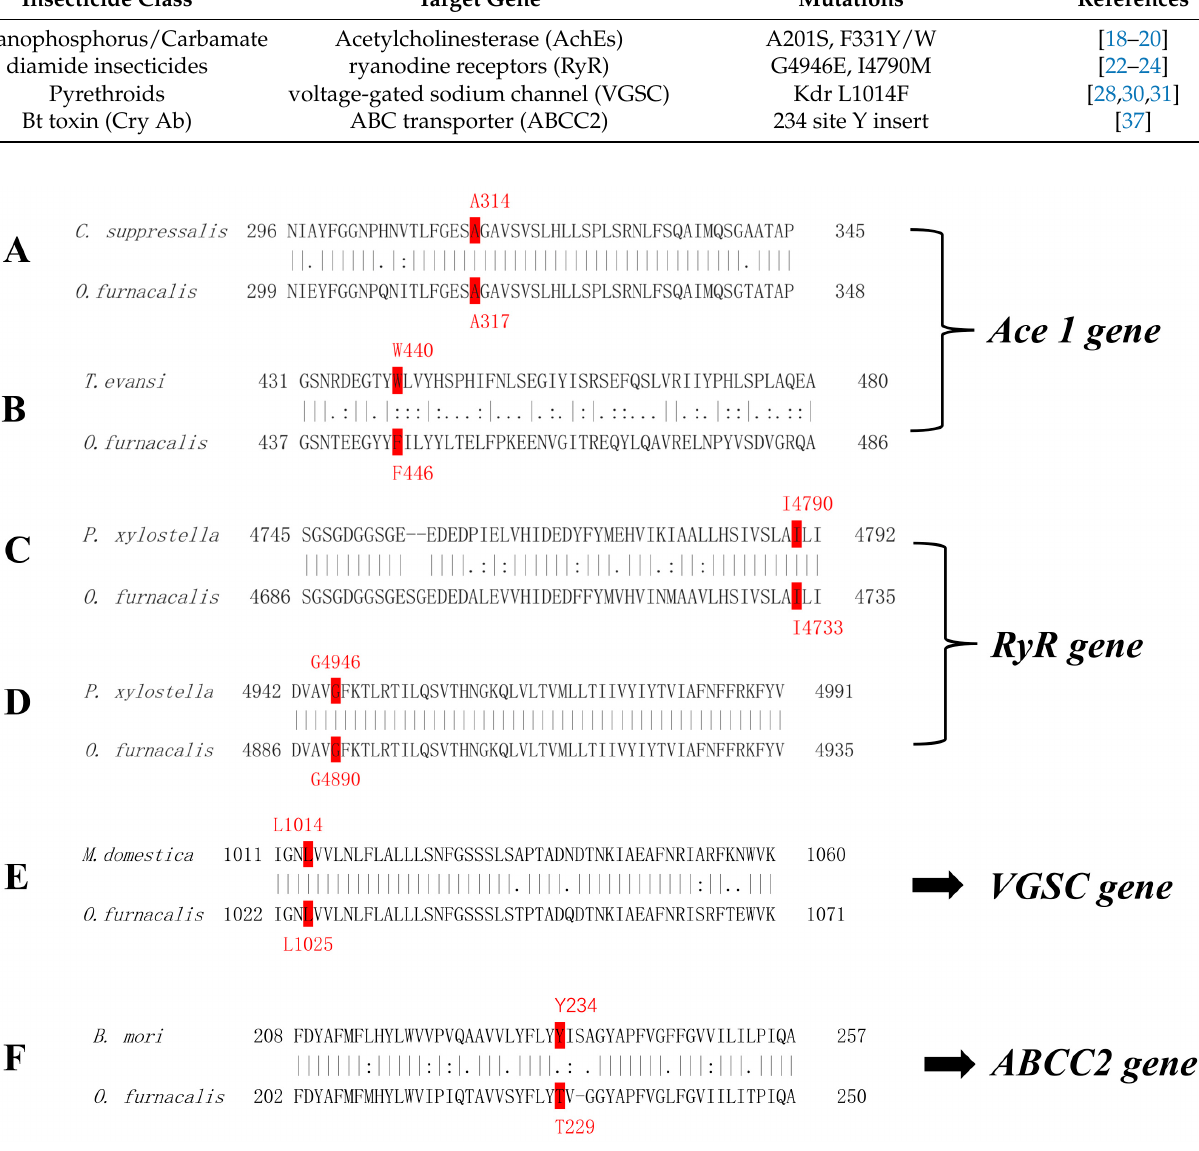
Figure 1. Comparison of the amino acid sequences of target genes between Ostrinia furnacalis and other species to locate the amino acid site of resistance mutation. ( A ) For A201S mutation, Ace1 gene amino acid sequence of O. furnacalis was compared with Chilo suppressalis [18]; ( B ) for F331Y/W mutation in Acetylcholinesterase 1 gene, amino acid sequence of O. furnacalis was compared with Tetranychus evansi [39]; ( C ) for I4790M mutation in Ryanodine receptors gene (RyR), amino acid se- quence of O. furnacalis was compared with Plutella xylostella [24]; ( D ) for G4946E mutation in RyR gene, amino acid sequence of O. furnacalis was compared with Plutella xylostella [23]; ( E ) for L1014F mutation in voltage-gated sodium channel (VGSC) gene, amino acid sequence of O. furnacalis was compared with Musca domestica [28]; ( F ) for 234-site Y insert in ABC transporter (ABCC2) gene, amino acid sequence of O. furnacalis was compared with Bombyx mori [37]. Table 3. The primer pairs used for ampli fi cation of a region containing key SNPs and the primers used in sequencing. Mutations Size of PCR Products (bp) Sequencing Primer Ace1-A201S